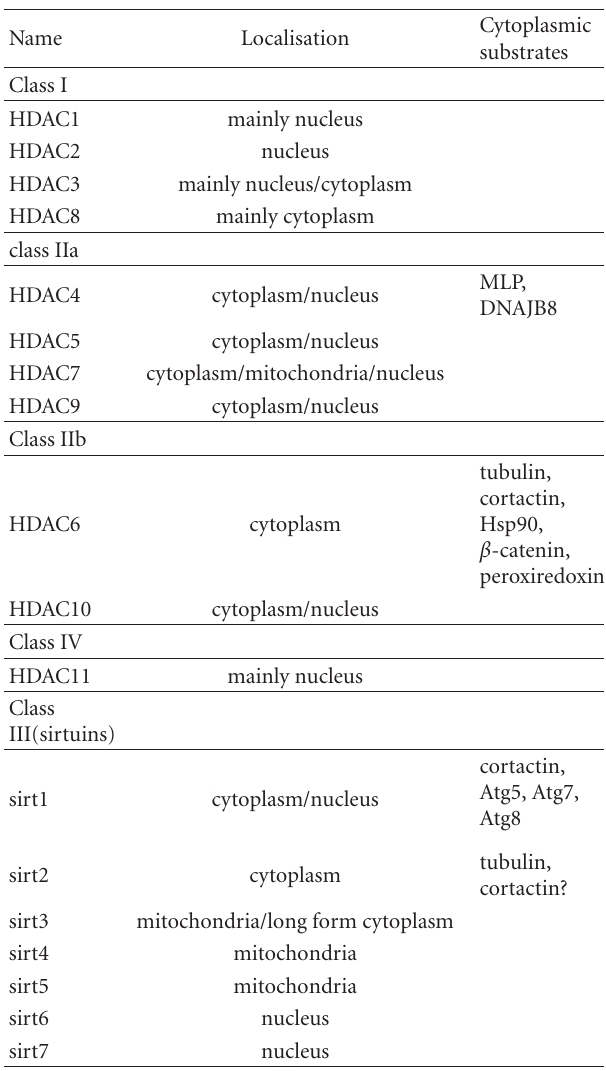
Table 2: Lysine (K)